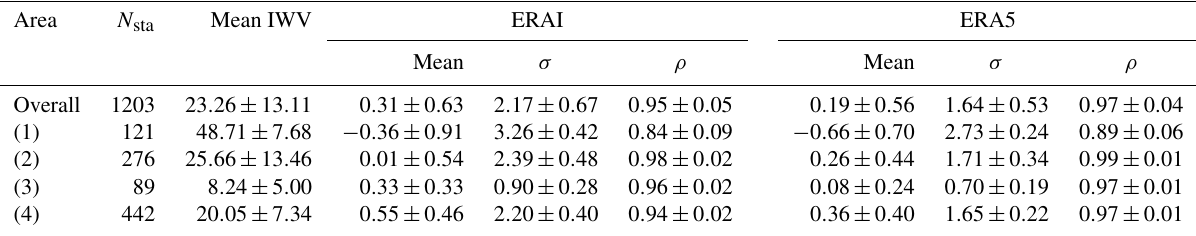
Figure 3. Histogram of IWV comparison statistics for ERAI (a, c, e) and ERA5 (b, d, f) . From top to bottom, bias (kgm − 2 , reanalysis minus GNSS), standard-deviation of difference (kgm − 2 ) and correlation coefficient. The inserted text indicates the mean value, the standard deviation, and the number of stations. Table 1. Statistics of IWV differences between ERAI, ERA5, and GNSS over all stations and over four domains: Caribbean (1), Northern the mean IWV from all GNSS stations on the area; “mean” is the mean difference (kgm − 2 , ERAI, ERA5 − GNSS), σ the standard deviation of difference (kgm − 2 ), and ρ the mean correlation coefficient. The values indicate the mean ± 1SD (standard deviation) over the stations in the domain. Note that some stations are outside of the four main